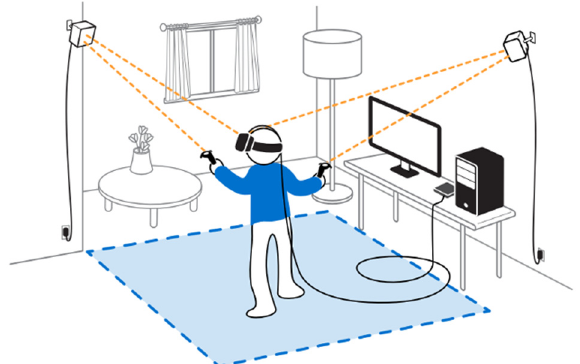
Figure 3. Setup of the HTC Vive Pro including the "Lighthouse" base stations tracking the moving two controller and headset in the blue interaction area (www.htc.com)